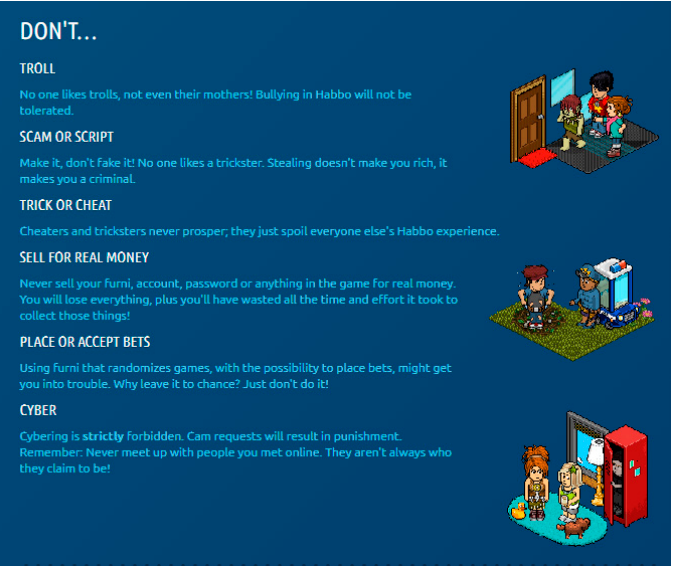
Figure 3. A screenshot of Habbo ’s Code of Conduct. There are six main rules under the